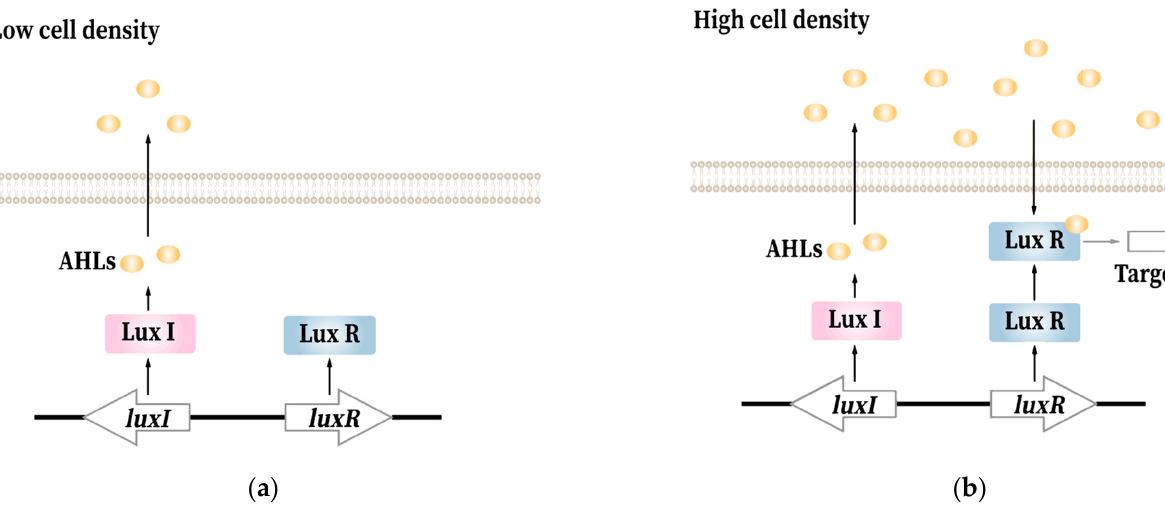
Figure 1. The mechanism of quorum sensing in Gram-negative bacteria: ( a ) At low bacterial cell density, LuxI catalyzes the synthesis of AHLs and then AHLs diffuse into the extracellular environment; ( b ) when bacteria are at high cell-density, AHLs diffuse into bacterial cell and bind to the receptor LuxR, and thus activate the transcription of genes under QS control.